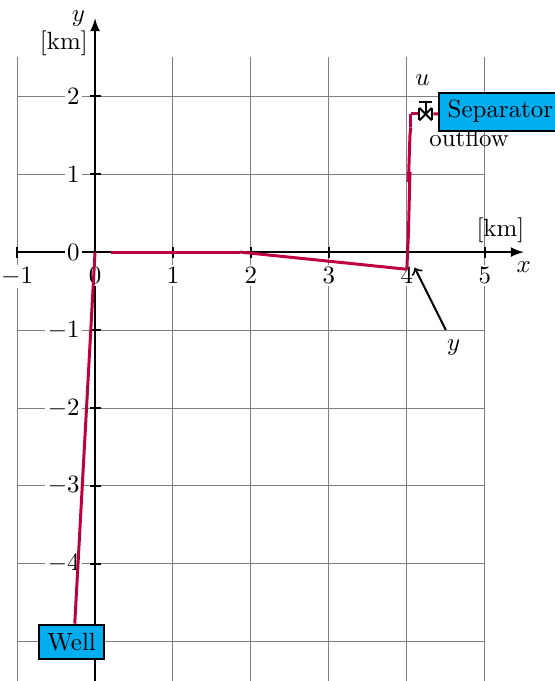
Figure 12: Illustration of the 3-phase well-pipeline-riser process integrated in the K-Spice/LedaFlow